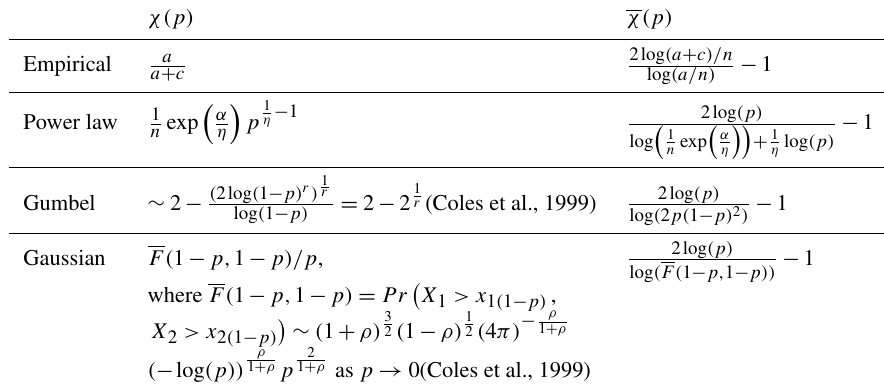
Table A1. Empirical and parametric forms for extremal dependence measures χ(p) and χ(p)